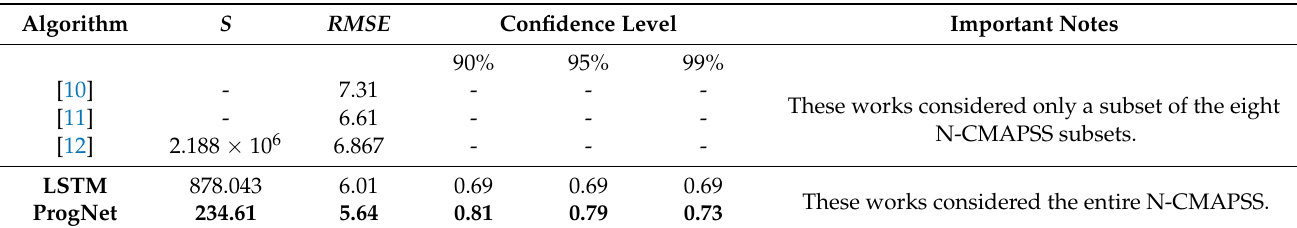
Table 4. Obtained evaluation